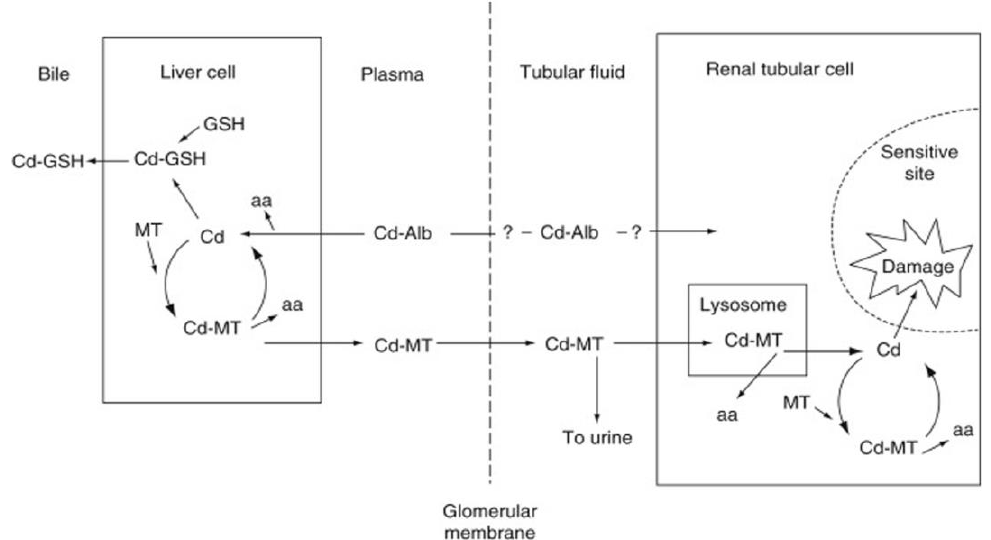
Figure 2. Basic flow scheme of Cd in the body demonstrating the role of binding forms in blood and MT synthesis and degradation. aa, amino acids; Alb, albumin GSH, glutathione; MT, metallothionein. Modified from [39].